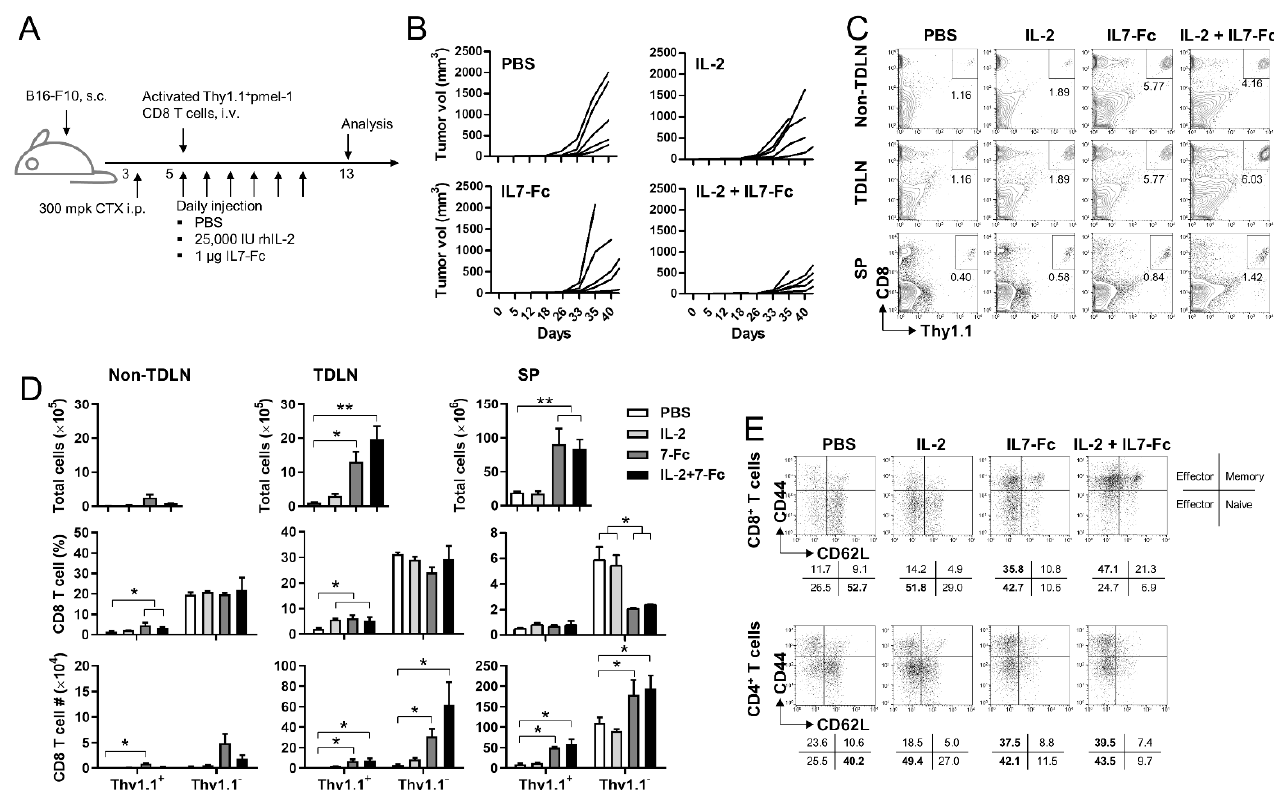
Figure 2. Anti-tumor effects of IL7-Fc with IL-2 in lymphopenia-induced B16-F10 melanoma-bearing B6 mice. ( A ) B16-F10 melanoma-bearing C57BL/6 mice were i.p. injected with 300 mpk of CTX on day 3 followed by 2 × 10 6 activated pmel-1 Thy1.1 + CD8 + T cells, and further treated with PBS, rhIL-2, hIL7-Fc, or rhIL-2 plus hIL7-Fc as described above. ( B ) The growth rate of B16-F10 melanoma cells. ( C ) Inguinal TDLN, popliteal non-TDLN, and spleen (SP) were collected from each group of mice on day 13 and single cell suspensions were stained with anti-CD8-PE-Cy5 and anti-Thy1.1-FITC. All samples were further stained with propidium iodide (PI) and subsequently analyzed using FACSCalbur (BD Bioscience). Live cells were gated and plotted as the indicated markers. ( D ) Absolute numbers of live cells in non-DLN, TDLN, and spleen. Percentages and absolute numbers of CD8 + T cells, the transferred pmel-1 Thy1.1 + CD8 + T cells, and the endogenous Thy1.1 − CD8 + T cells in non-TDLN, TDLN, and spleen on day 13. ( E ) TDLN cells were stained with anti-CD44-PE, anti-CD62L-FITC, and anti-Thy1.1-PE-Cy5 along with anti-CD4-APC or anti-CD8-APC. Gated Thy1.1-negative CD4 + or CD8 + cells were plotted as CD44 vs. CD62L. Data are from three independent experiments with 5 ( B ) or 3 ( C , D ) mice per experiment. Student’s t -test was performed in D, and the results are expressed as mean ± SD (* p < 0.05; ** p < 0.01) .